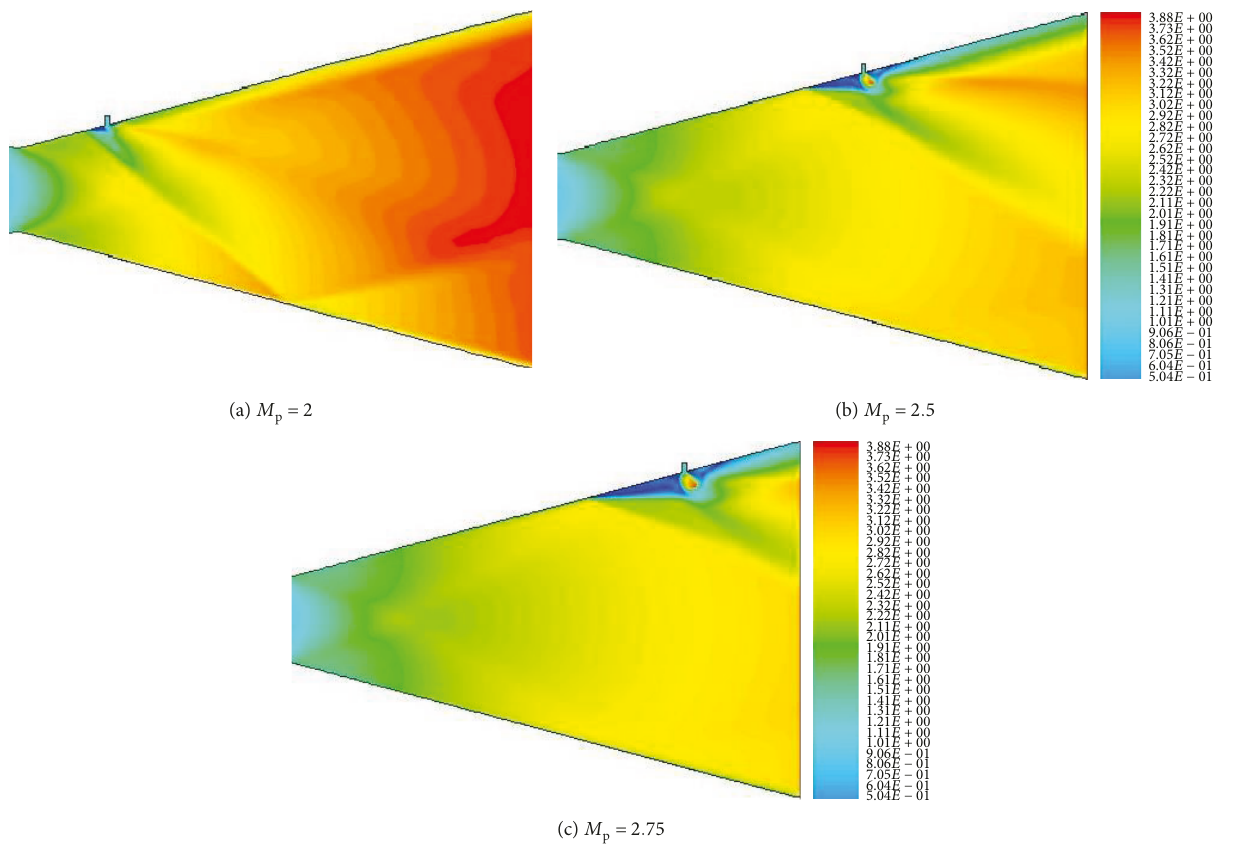
Figure 12: The in fl uence of injection location on fl ow fi eld structure (Mach number